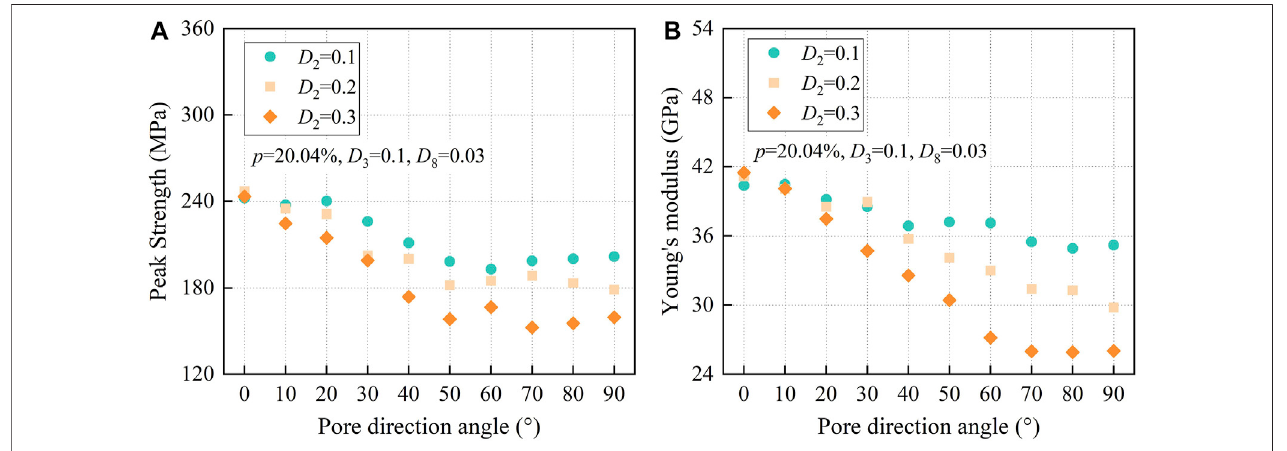
FIGURE 9 | Results of (A) compressive peak strength; and (B) corresponding Young ’ s modulus for groups A-D2-1, A-D2-2, and A-D2-3.